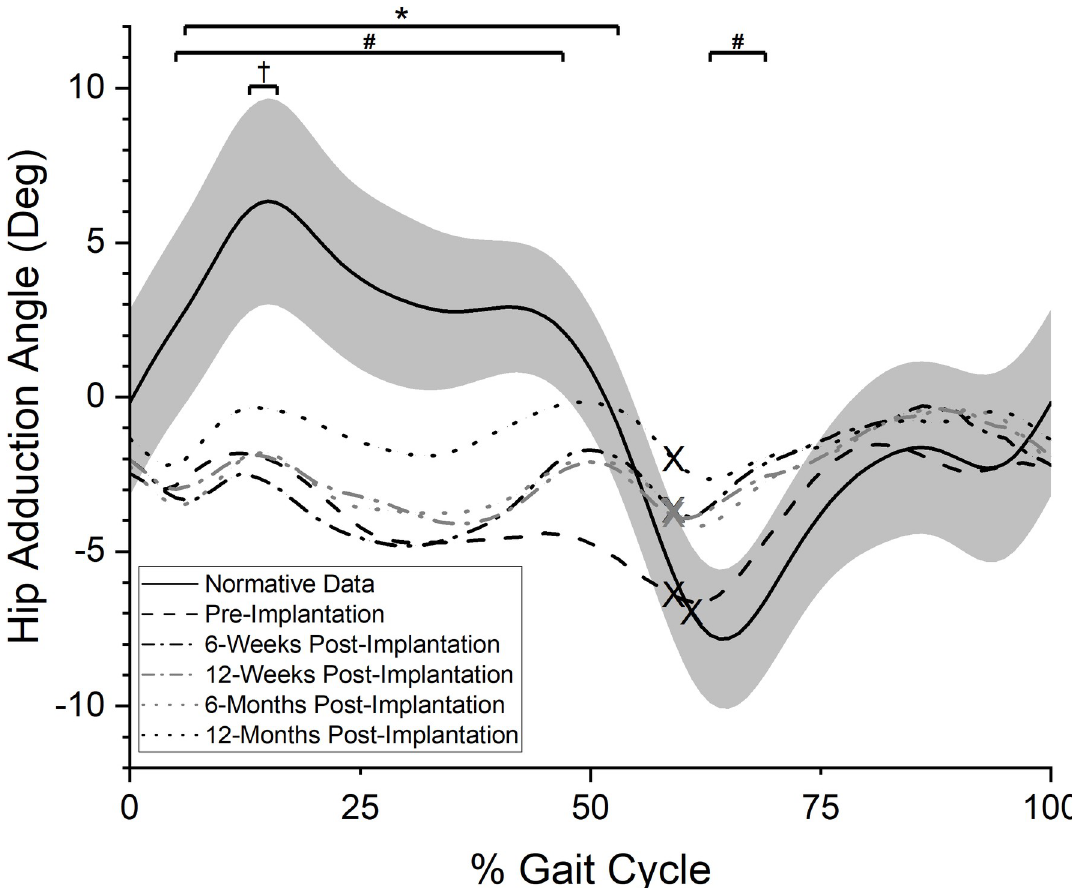
Fig 2. Frontal plane hip angle. Averaged, normalized frontal plane hip angle values over the prosthetic side gait cycle (0% = POP side heel strike, 100% = subsequent POP side heel strike). “X” marks represent the mean toe-off event for each curve. Positive values indicate hip adduction relative to the pelvis, while negative values indicate hip abduction relative to the pelvis. Solid black line indicates reference values for individuals without TFA while grey band indicates plus or minus one standard deviation of the reference data. � : period of statistically significant difference in pre-implantation test values from reference data (p < 0.01); #: periods of statistically significant difference in 6-week post-implantation test values from reference data (p < 0.01 and p = 0.08); †: period of statistically significant difference in 12-month post-implantation test values from reference data (p =